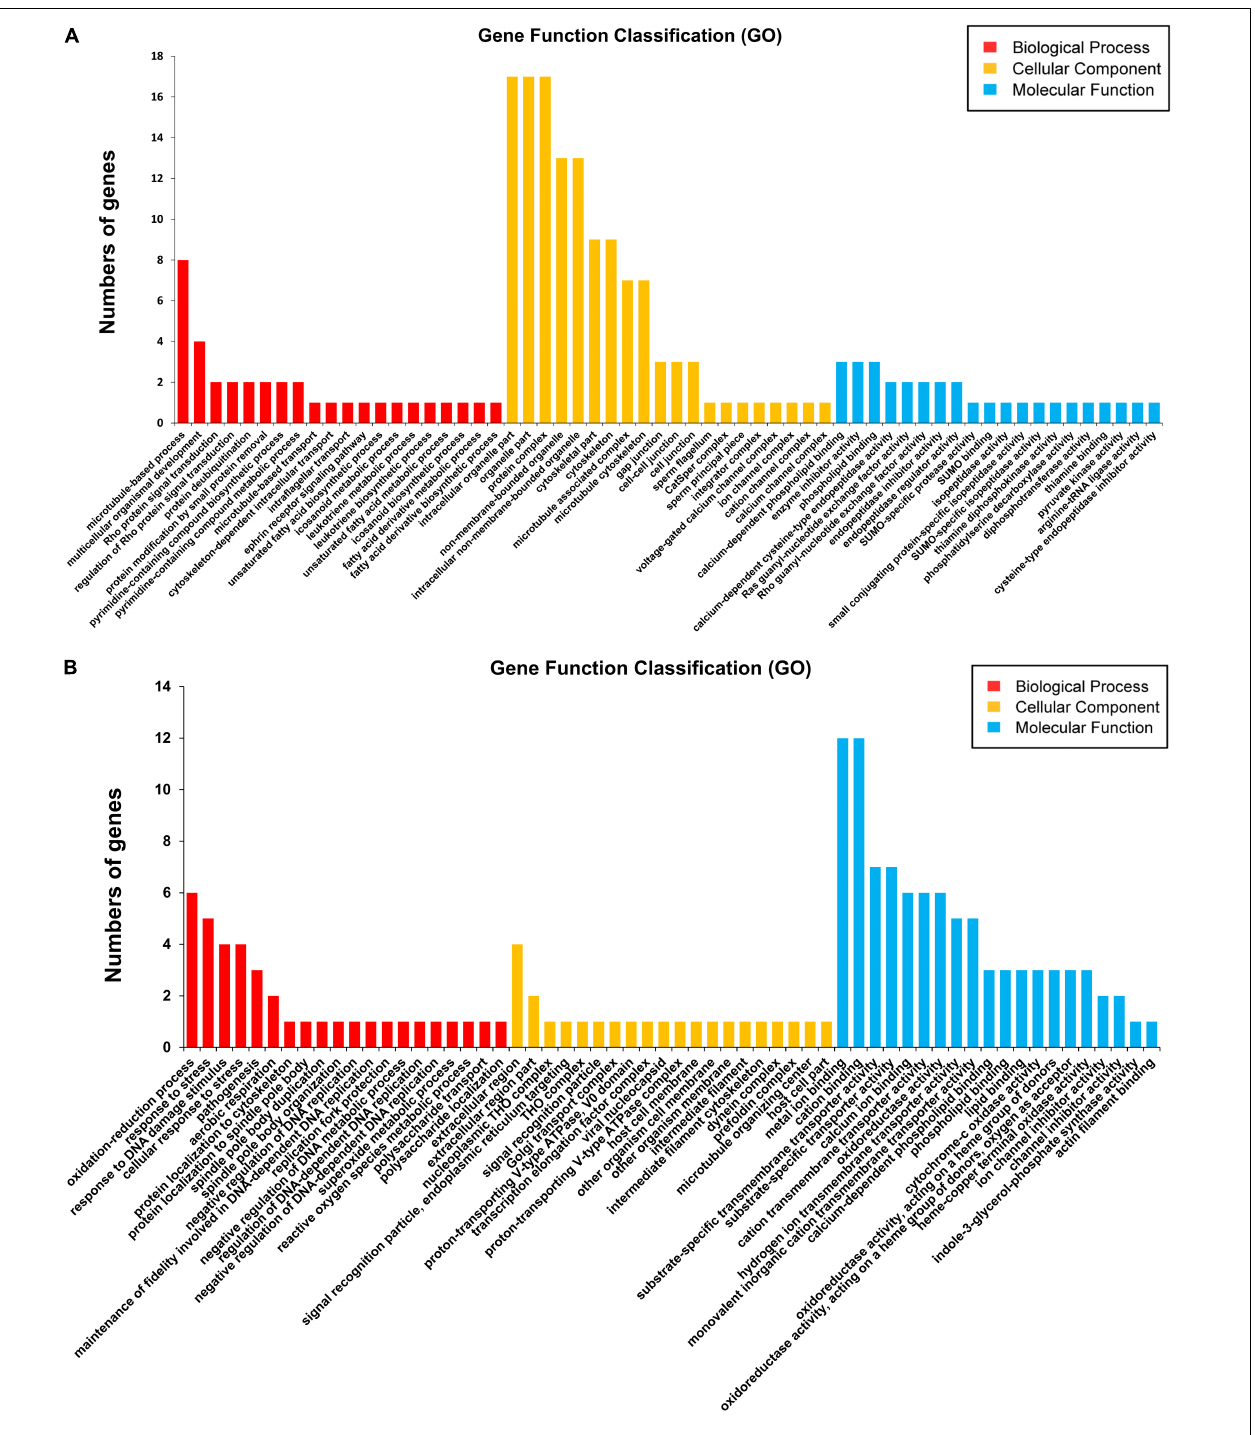
FIGURE 5 | Gene ontology (GO) analysis (top 20) of the differentially expressed mRNAs in Schistosoma japonicum from BALB/c and SCID mice. The Blast2Go program defined the GO terms into three categories: biological process ( BP ), cellular component ( CC ), and molecular function ( MF ). Data without assigned GO terms were excluded from the graph. (A,B) GO analyses (top 20) of the differentially expressed mRNAs between S_F vs. B_F (A) and between S_M vs. B_M (B) . The Y -axis ‘ number of genes’ indicates the number of differentially expressed mRNAs between S_F vs. B_F or S_M vs. B_M, which belong to one of the indicated GO terms by GO